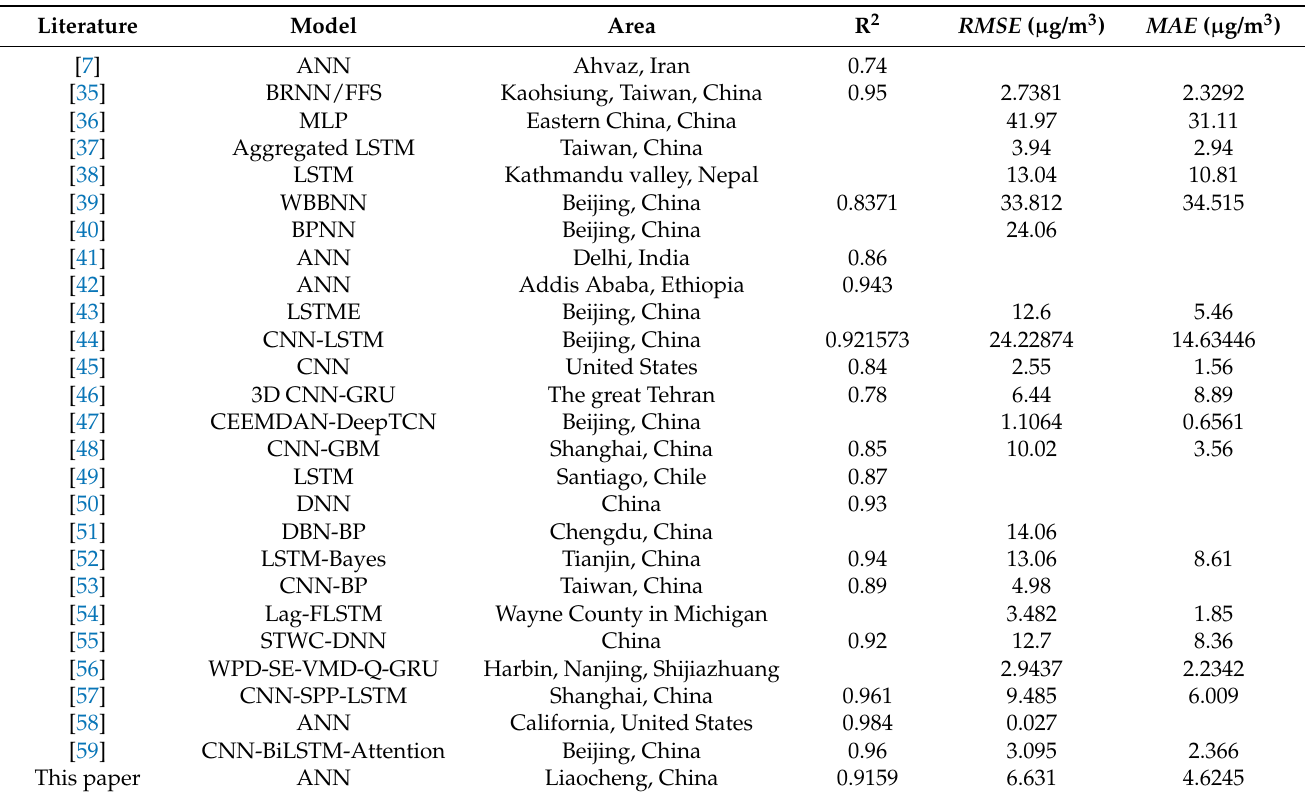
Table 7. The difference between existing PM 2.5 models and the proposed ANN